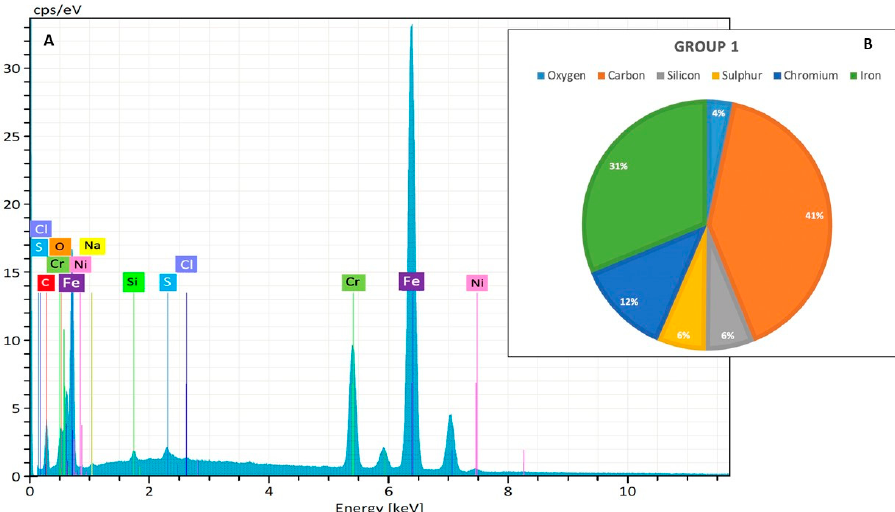
Figure 3. ( A ) The superficial composition of new zirconia drills, without any treatment (keV= kilo- electron-volt, accelerating voltage range used for EDX analysis; cps/eV: counts per second per electron-volt). ( B ) The atomic percentage (%), that represent the % concentration of each element on the same sample.